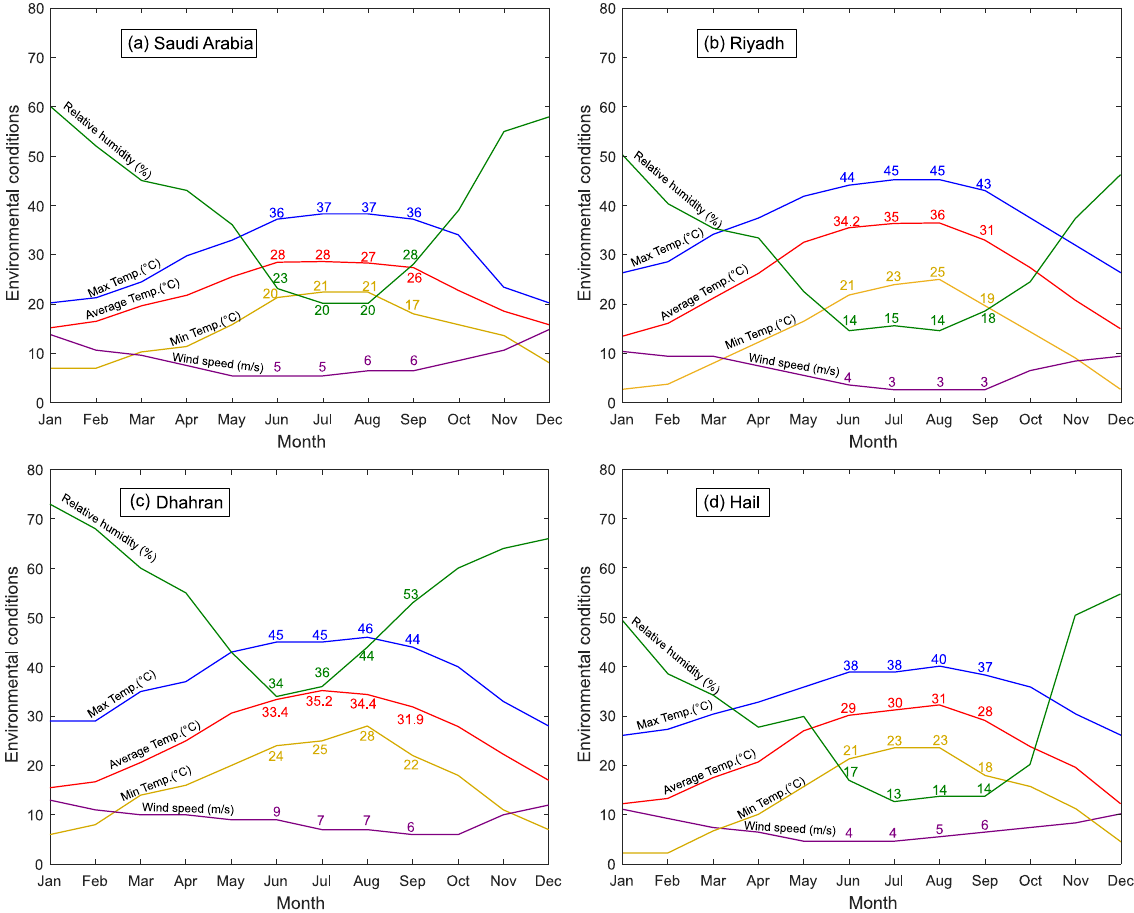
Figure 2. Selected environments climate graphs [41].